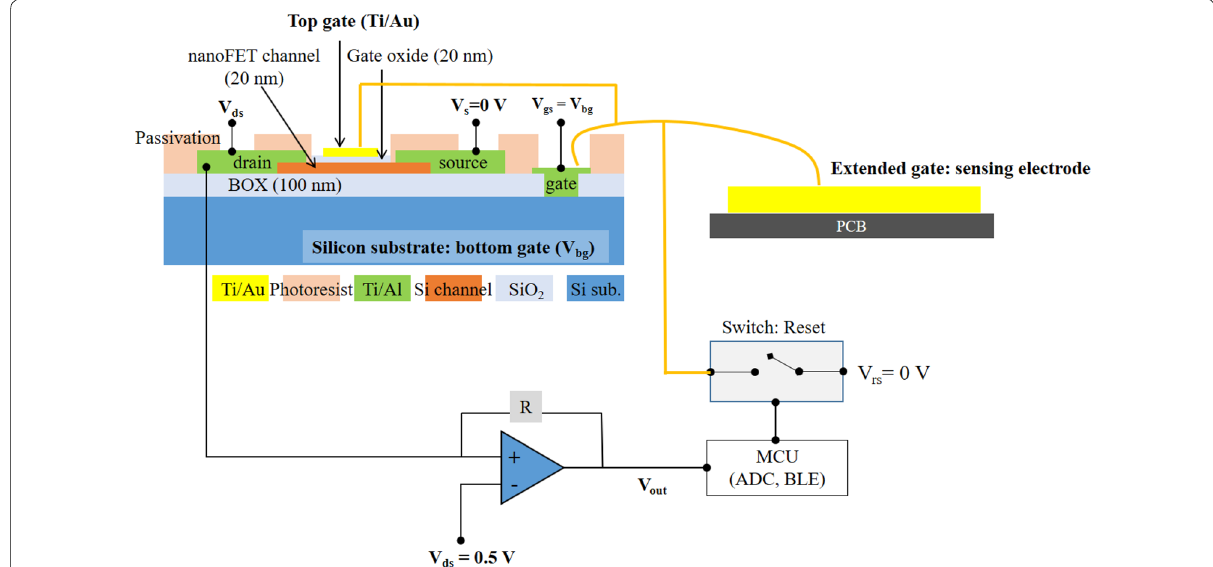
Fig. 1 Schematic of nanoFET device with the extended gate electrode and a read‑out circuit for ions